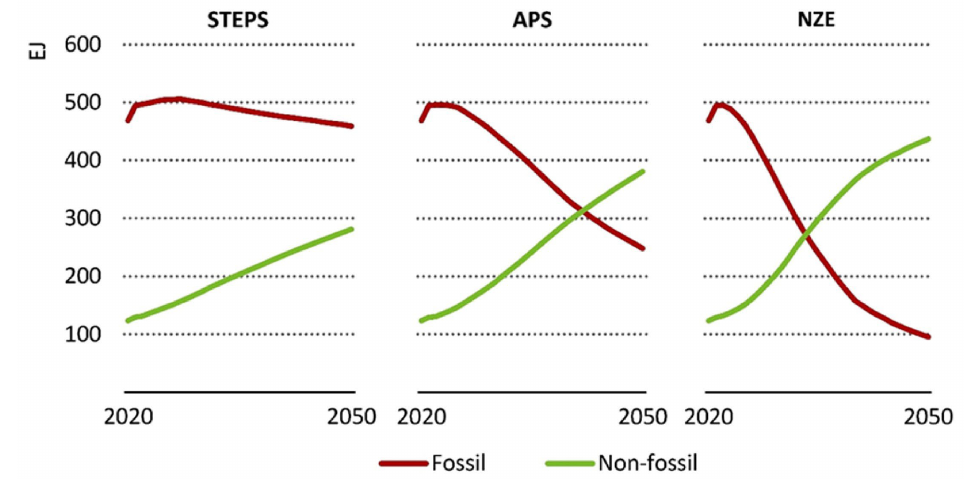
Figure 3. Supply of non-fossil and fossil energy by scenario, 2020 – 2050 [58] .